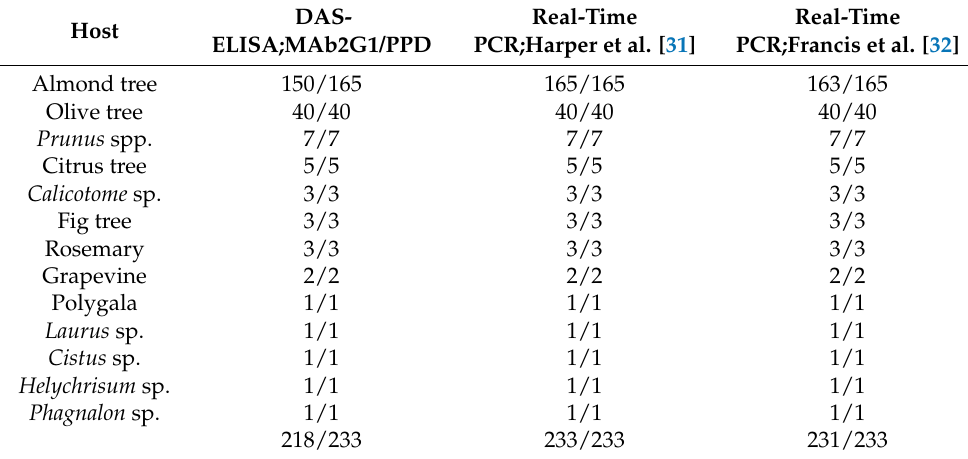
Table 3. Analysis of plant samples for detection of Xylella fastidiosa by DAS-ELISA Mab